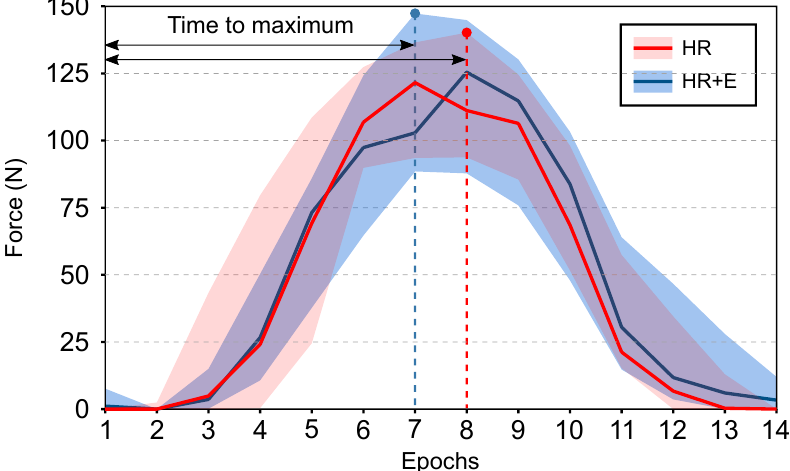
Figure 5. Evolution of the resultant force in the instrumented hand rail by epochs of 200 ms. Shaded areas contains all of the mean values of all participants in that